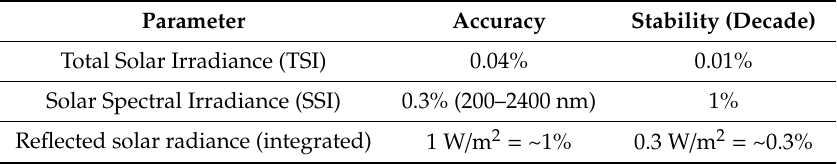
Table 1. Global climate observing system (GCOS) requirements driving the radiometric performance drivers of